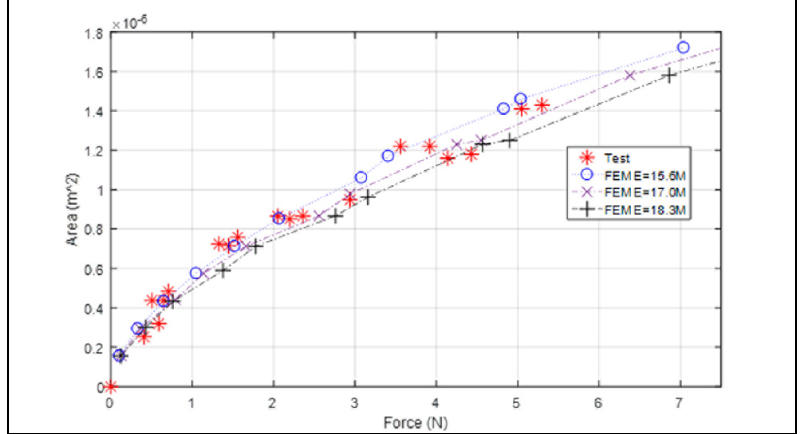
Figure 3. Contact area vs. force by FEM and